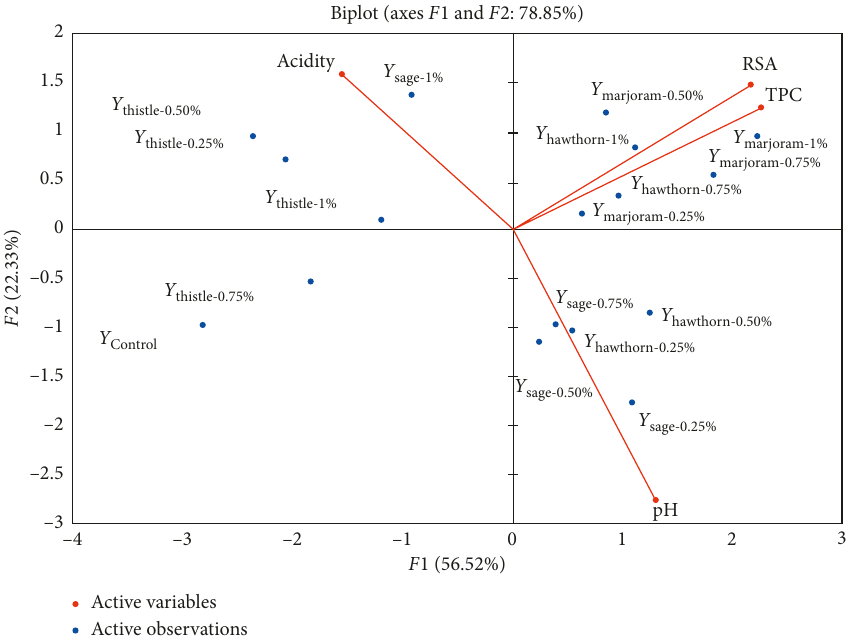
Figure 10: PCA loadings of the yogurt characteristics after 28 days of